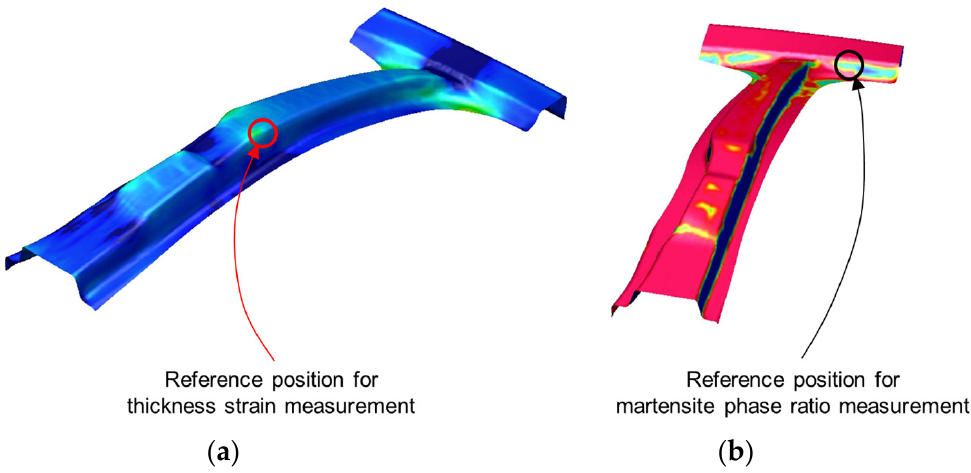
Figure 11. Reference positions for comparing ( a ) thickness strain and ( b ) martensitic phase ratio in B-pillar parts .